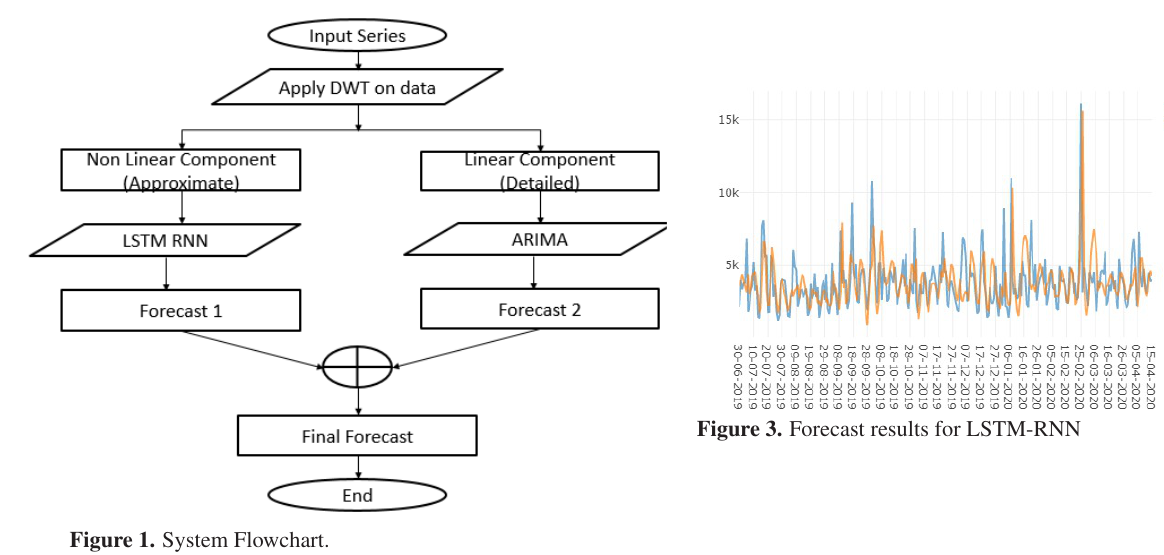
Figure 1. System Flowchart.